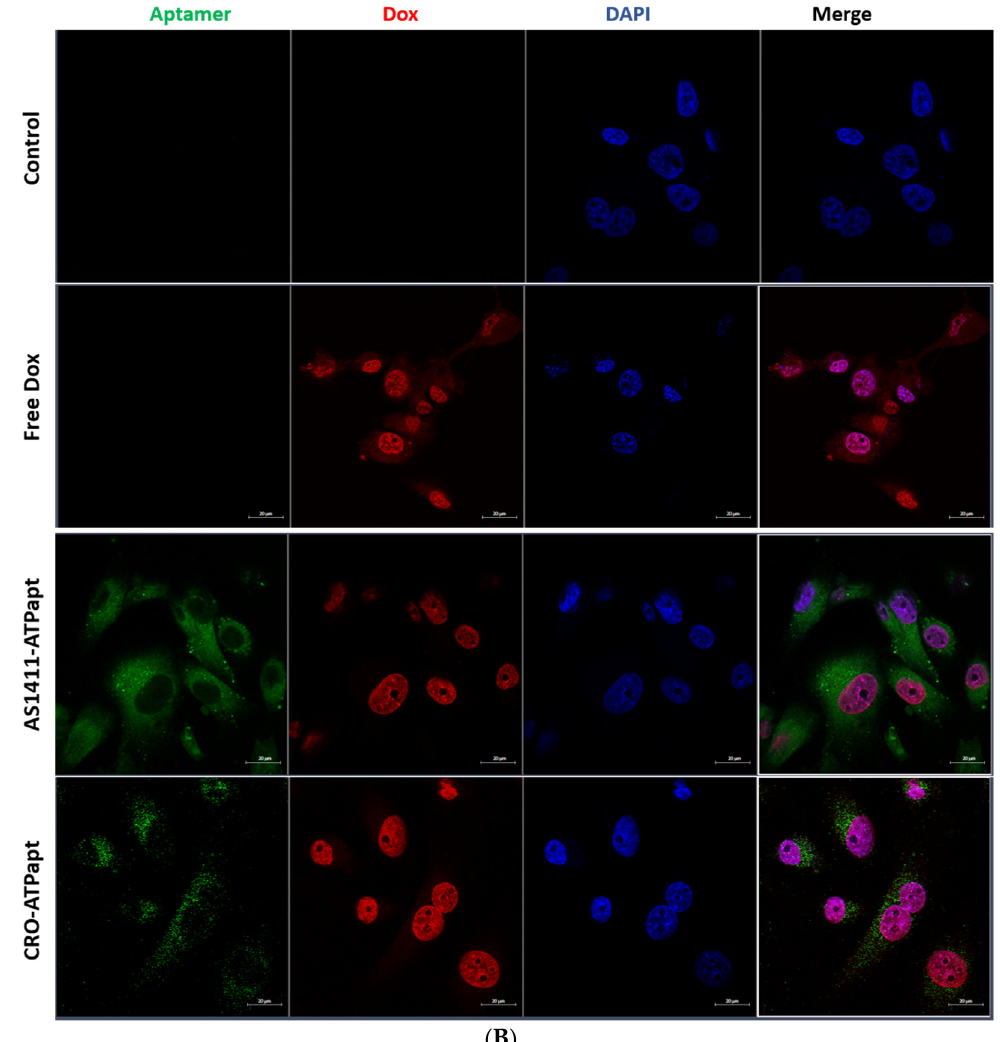
Figure 8. Cellular uptake of chimeras demonstrated by confocal microscopy. The cancer cells ( A ) MCF-7 and ( B ) U87 were incubated with a culture medium containing free doxorubicin or doxorubicin loaded into fluorophore-labeled chimeras. For negative control, cells were incubated with complete culture medium without treatment. After incubation at 37 °C for 3 h, the cells were fixed in 4% formaldehyde and then analyzed by confocal laser microscope (Dox showed red fluorescence, Cy5-labeled ATP aptamer showed green fluorescence, and the nuclei stained with DAPI showed blue fluorescence).